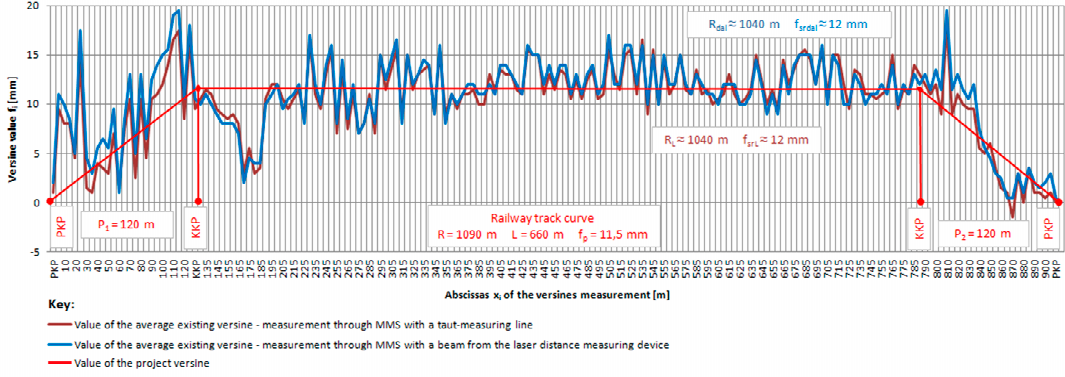
Figure 8. A diagram of horizontal versines in the exploited track (measurement on the basis of the measurement chord c i = 10 m (own Figure).